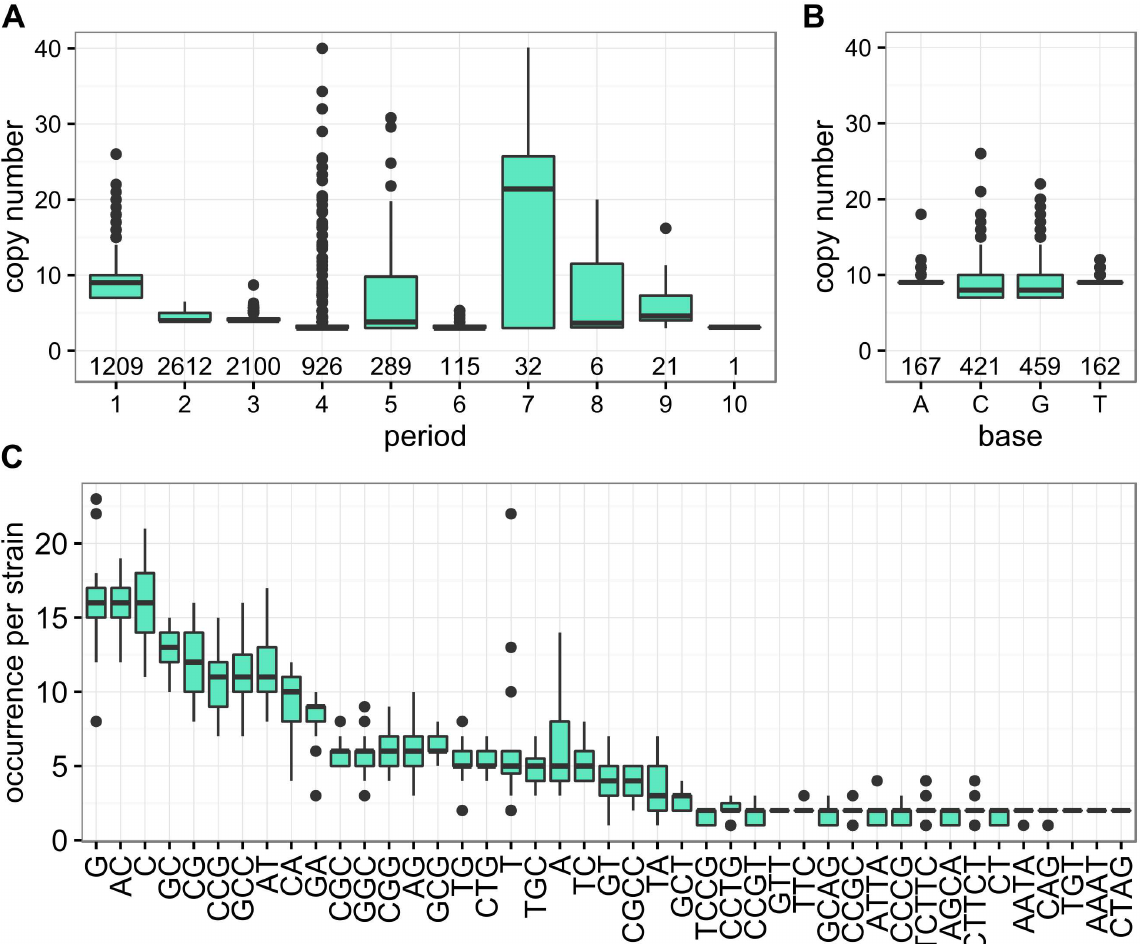
Fig 1. Structural properties of SSR loci in 27 meningococcal genomes. A) Characterization of SSRs by periodlengthand copy number across all 27 assessed N . meningitidis genomes.The number of SSRs for each periodlengthis indicatedbelowthe box- plots. B) Copy number distribution of the four different SSRs of periodlengthone(A, C, G and T homopolymer tracts) across all 27 assessed N . meningitidis genomes.The numberof SSRs for each base is indicatedbelowthe box-plots. C) Occurrence of the most frequent repeat motifs per strain, orderedby median occurrence per strain. Only motifs with a medianoccurrence per strain of greater than 1.5 are